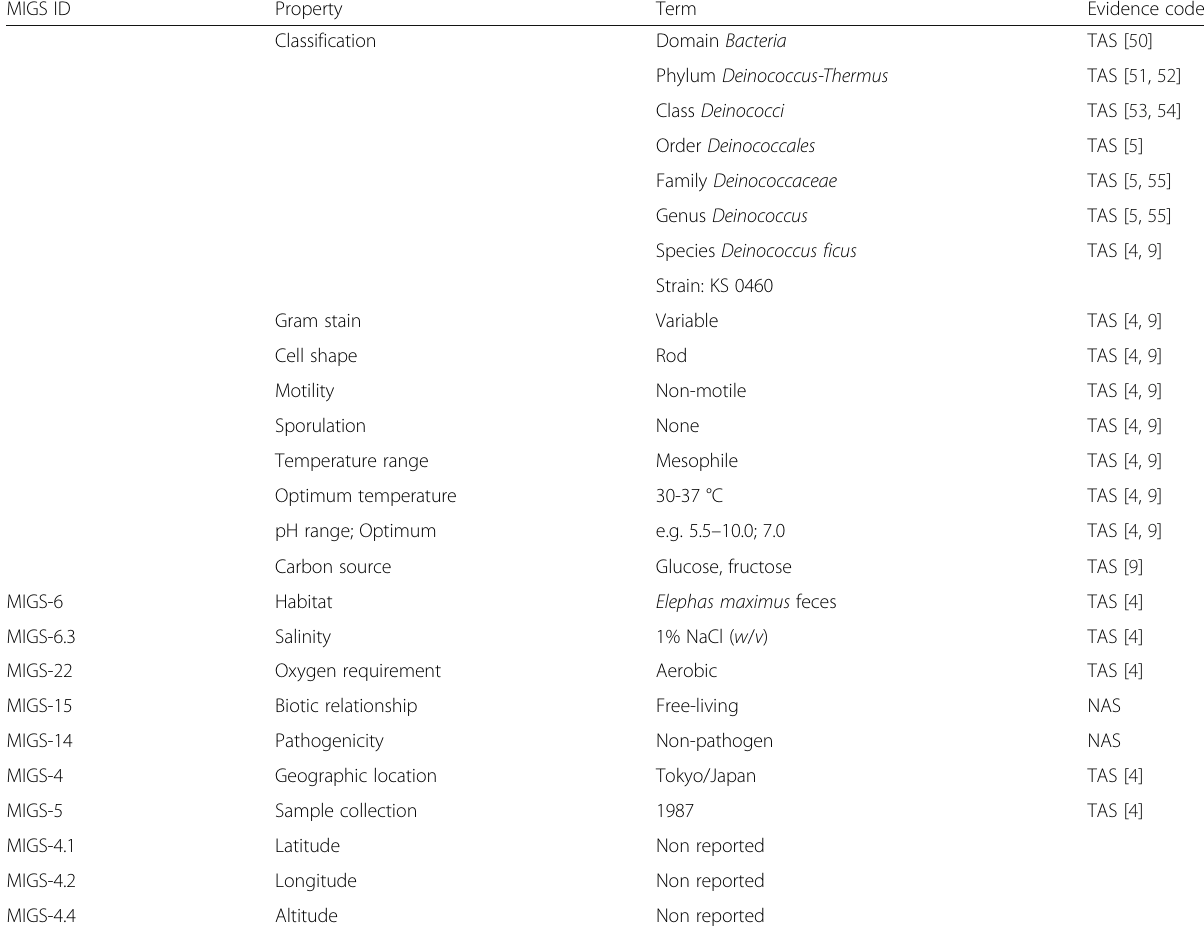
Table 1 Classification and general features of Deinococcus ficus KS 0460 according to MIGS recommendations